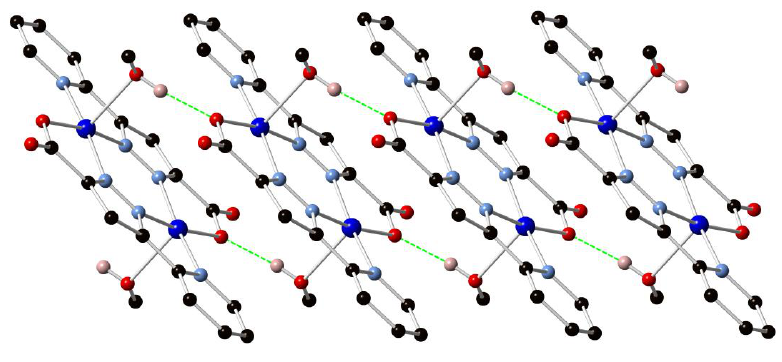
Figure 3. Extended structure of 1 showing the one-dimensional hydrogen-bonded chain formed between the coordinating methanol molecules and the non-coordinating carboxylate oxygen atoms. Hydrogen atoms not taking part in hydrogen bonding omitted for